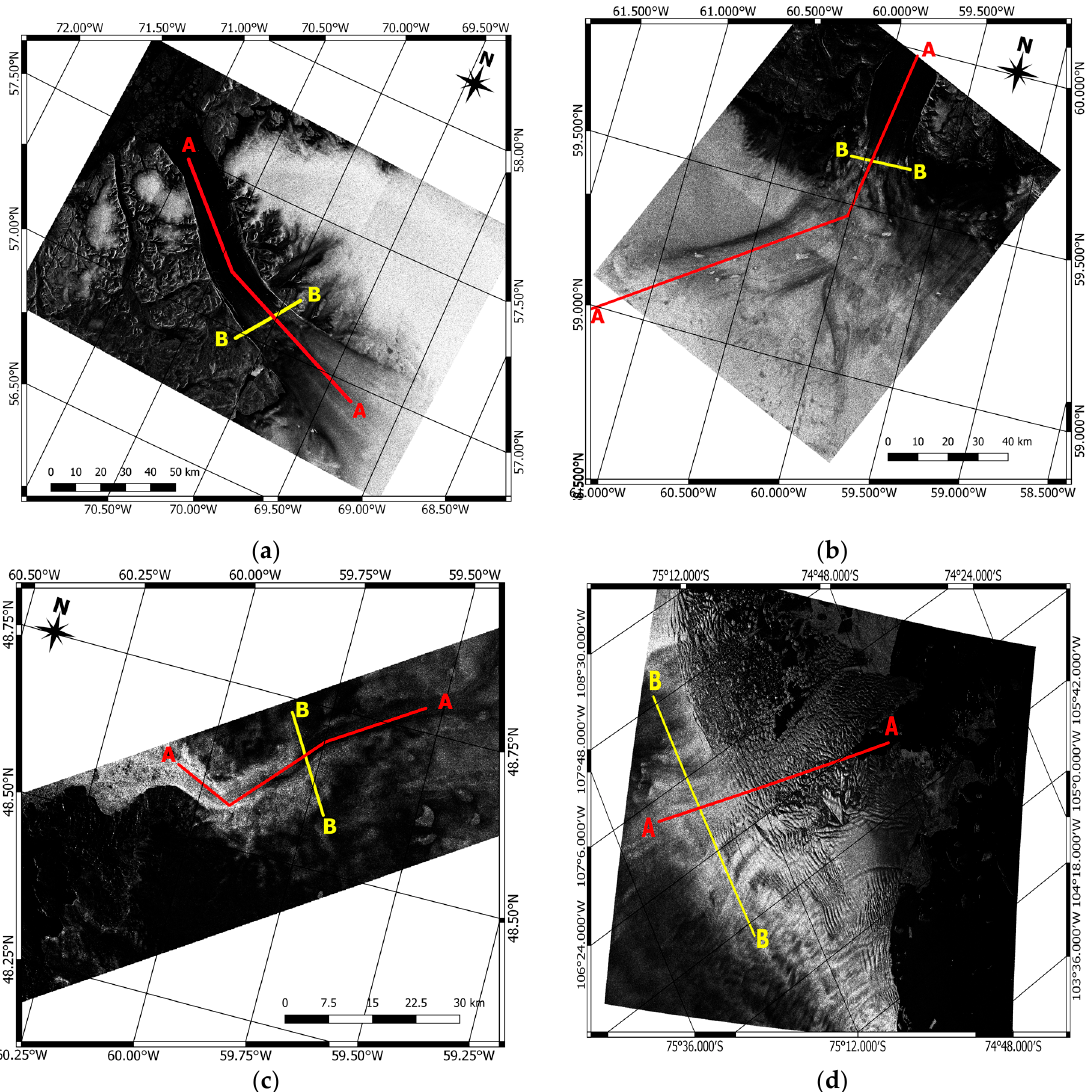
Figure 2. SAR images (all acquired in right ascending orbit) of the test sites with the corresponding analyzed transects (AA—along flow, BB—across flow). ( a ) Petermann glacier, ( b ) Nioghalvfjerdsfjorden, ( c ) Jakobshavn Isbræ and ( d ) Thwaites glacier.